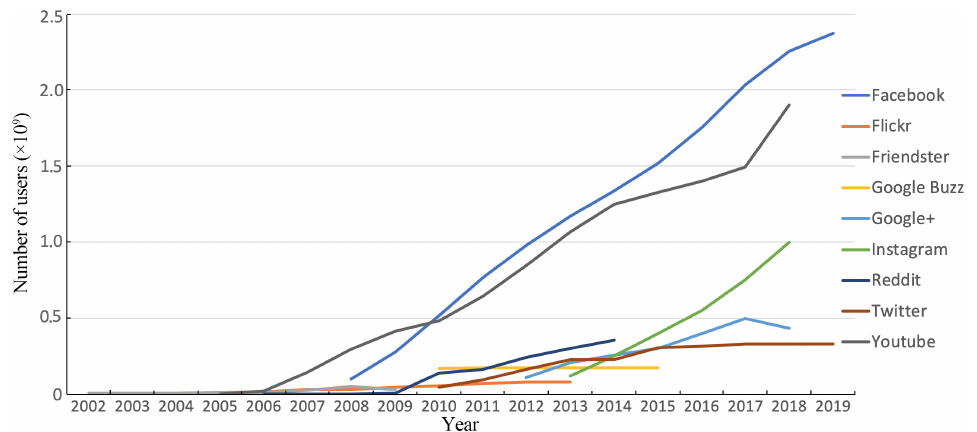
Fig. 3 Number of users using social media platforms from 2002 to 2019.